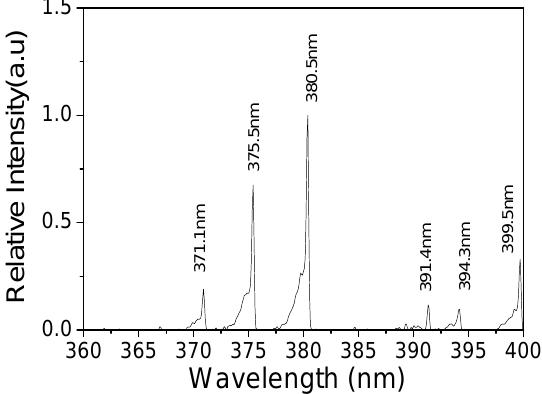
Figure 8. Normalized optical emission spectra of the plasma device with un ‐ fluorinated PI ( V pp = 10 kV, f = 6 kHz).